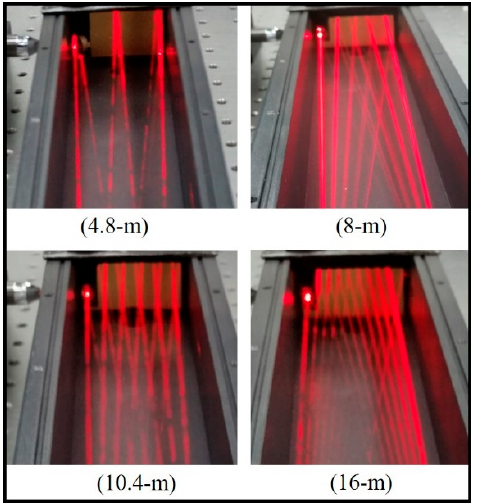
Figure 4. Patterns of different pathlengths in the NDIR gas chamber.